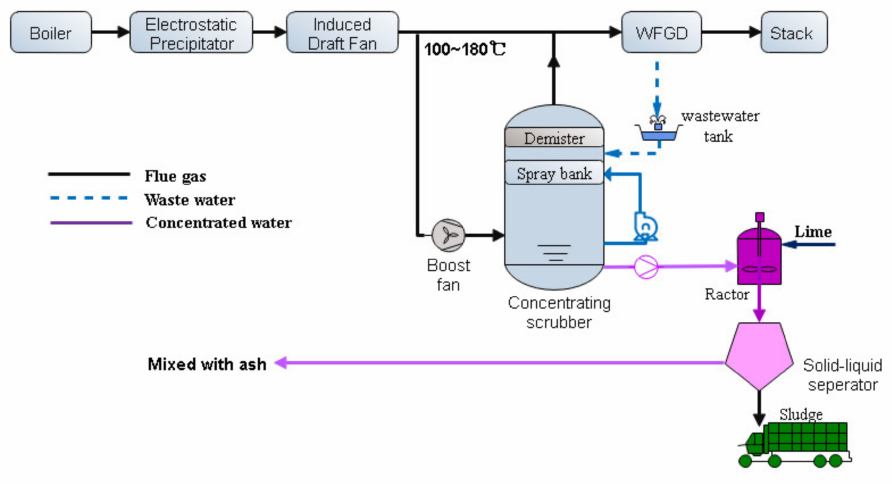
Figure 1. Concept design of the new WFGD wastewater treatment